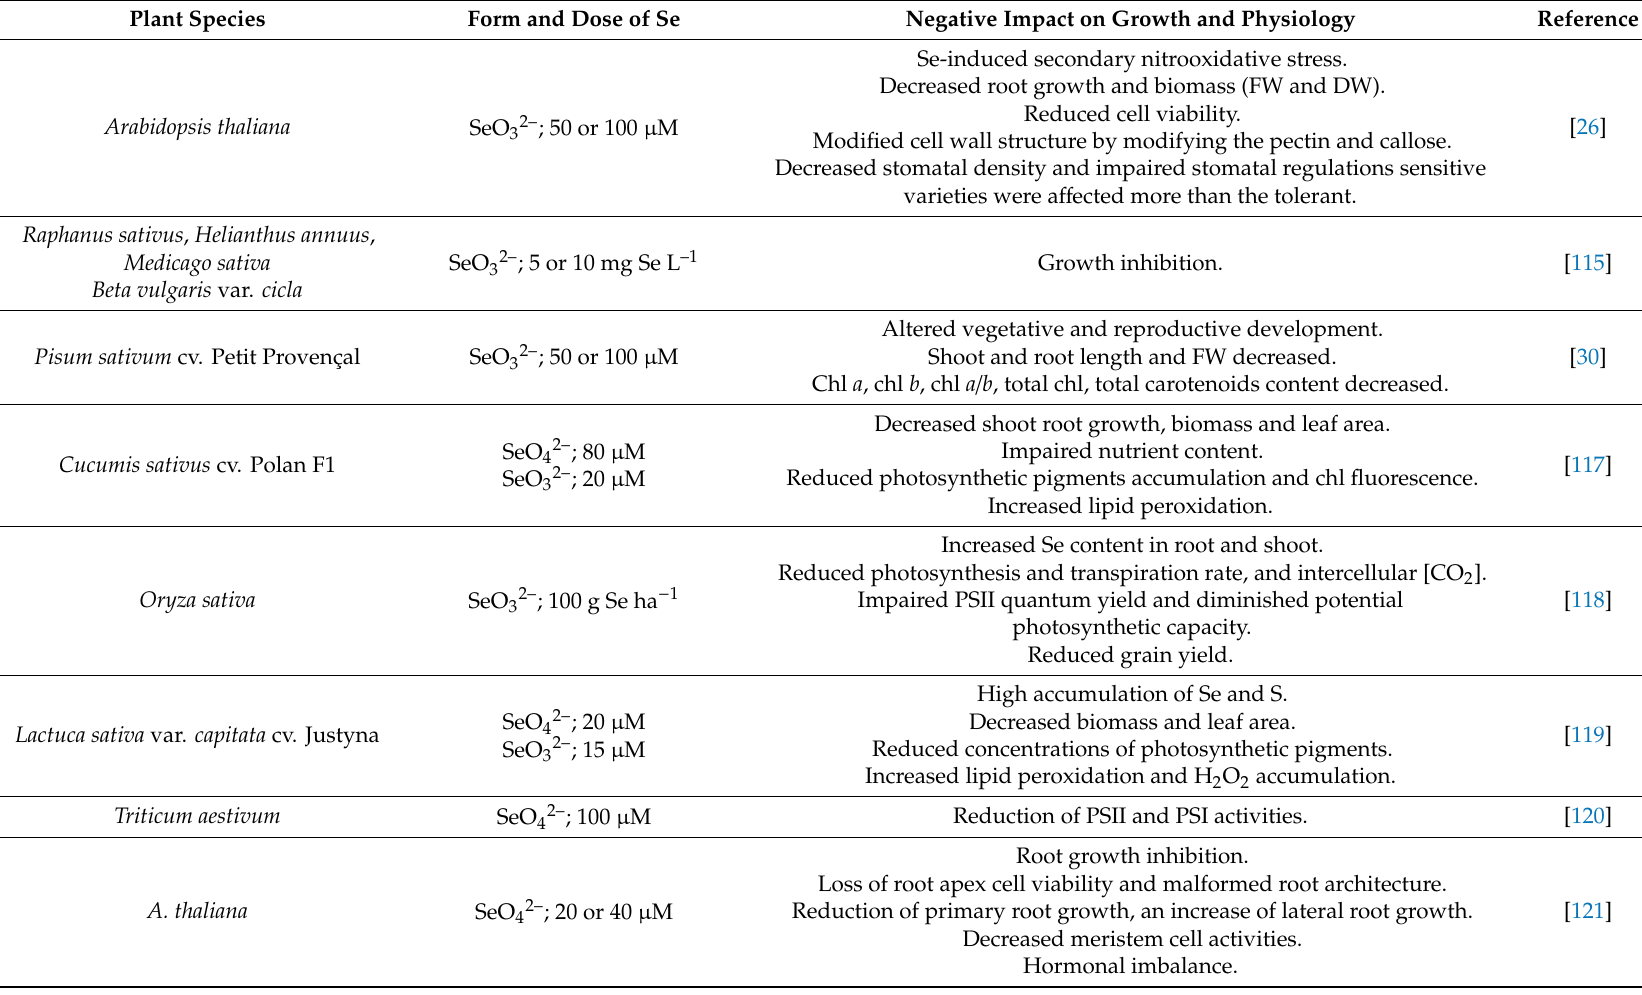
Table 1. Toxic e ff ects of Se on the growth and physiological processes in